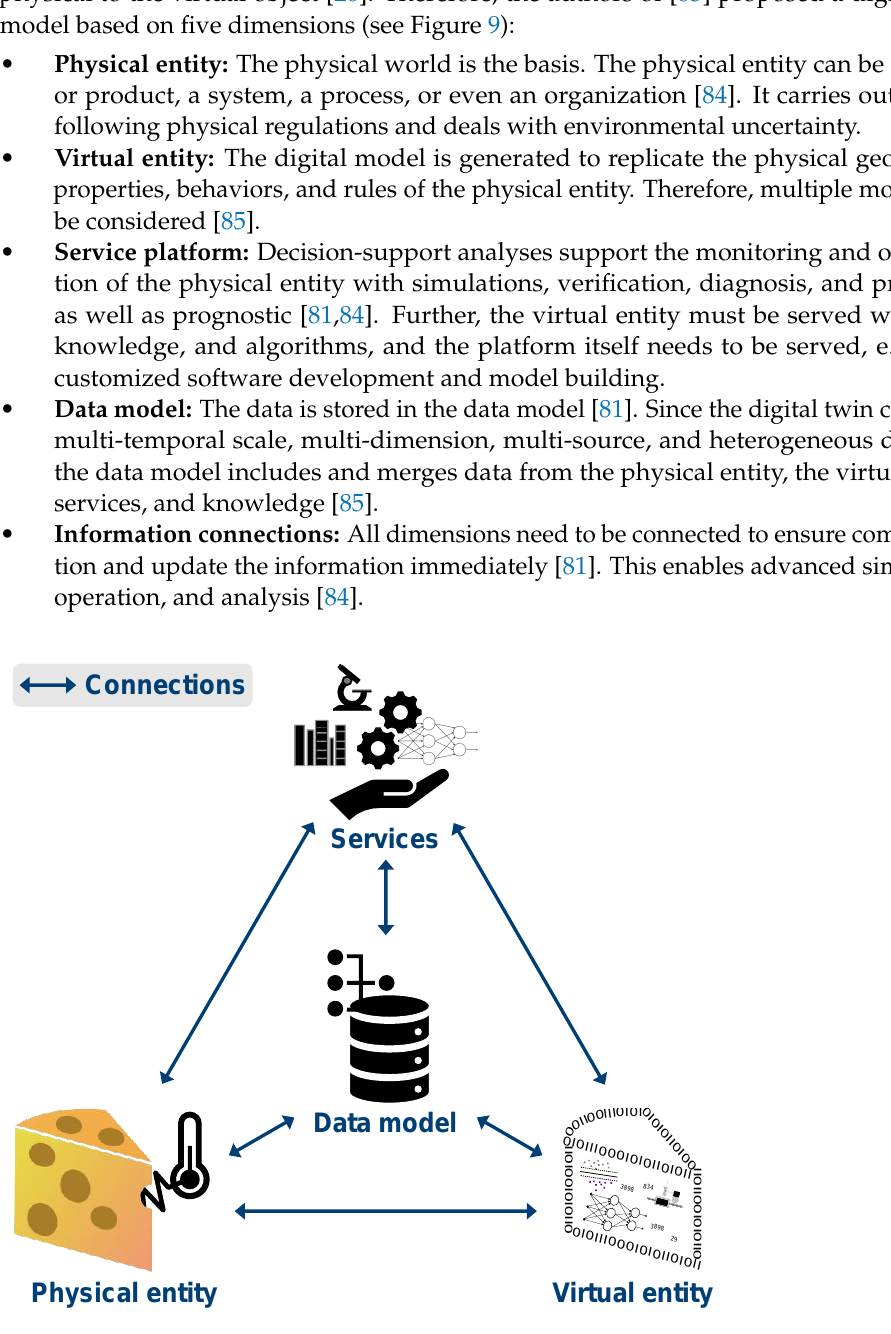
Figure 9. The five-dimensional digital twin concept (adapted from [85]): Digital twins consist of a physical as well as a virtual entity, which are supported by several services. Data are fused and stored centralized. These four dimensions must be connected with each other, creating the fifth